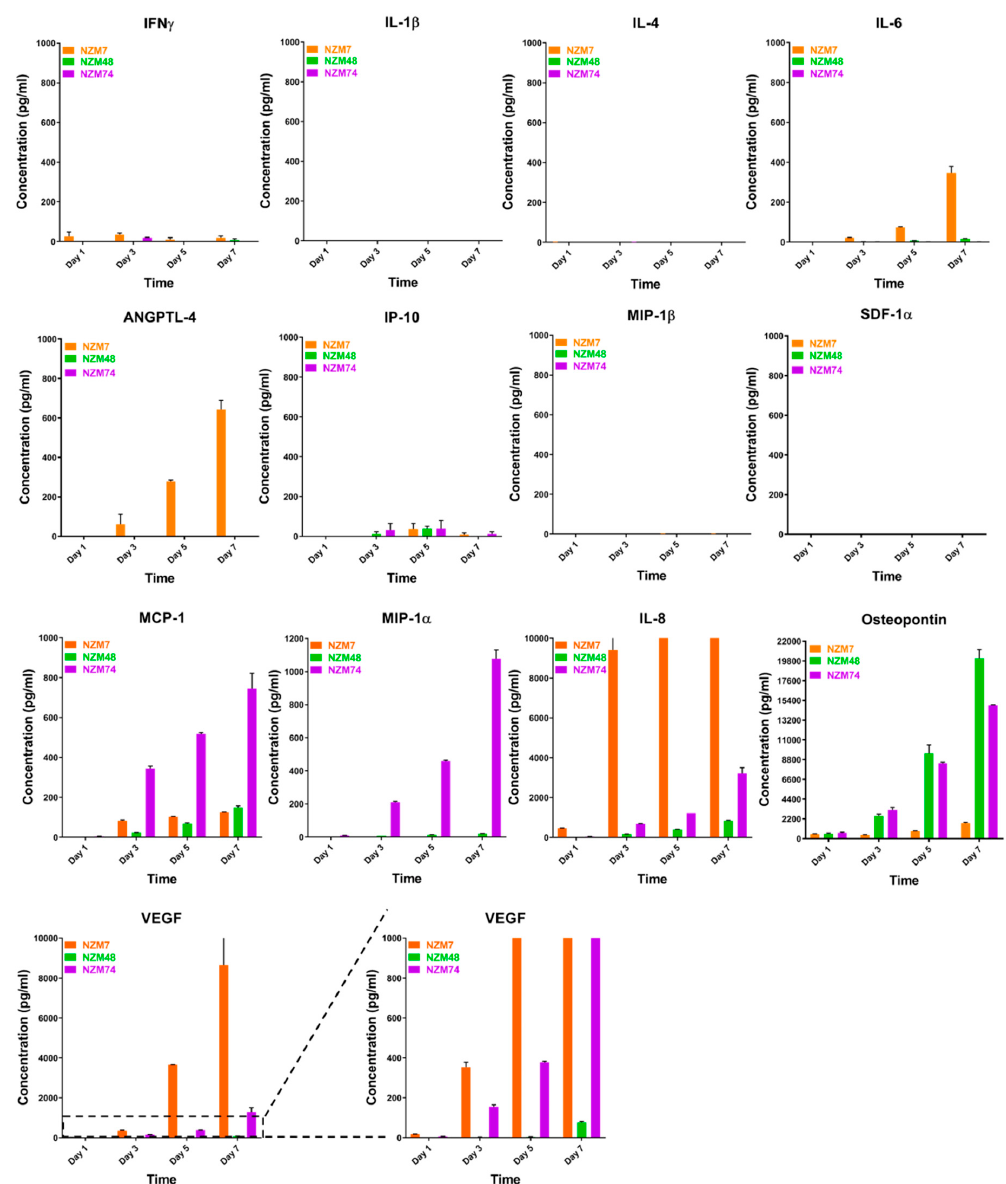
Figure 2. Quantitative expression of secreted factors in melanoma conditioned media. Concentration of 13 selected secreted factors of interest in melanoma conditioned media over time was measured by CBA or Luminex. Three NZM lines were tested. Conditioned media was collected from Day 1 (day of cell passage) on alternate days until Day 7 (~90% confluent). Note that for IL-8 and VEGF, the Y-axes are cut-o ff at max reliable detection range. Data are from one experiment showing the mean ± SEM ( n = 3), representative of at least two independent